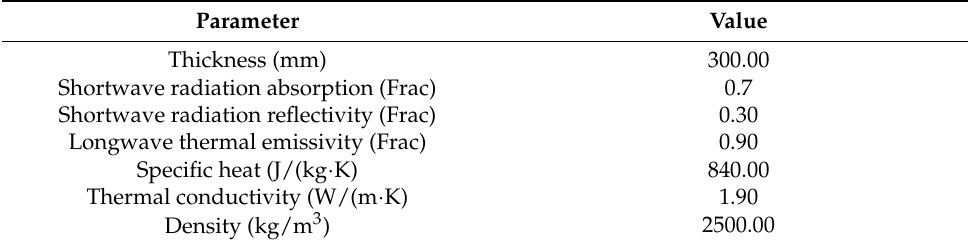
Table 2. Attributes of reinforced concrete.